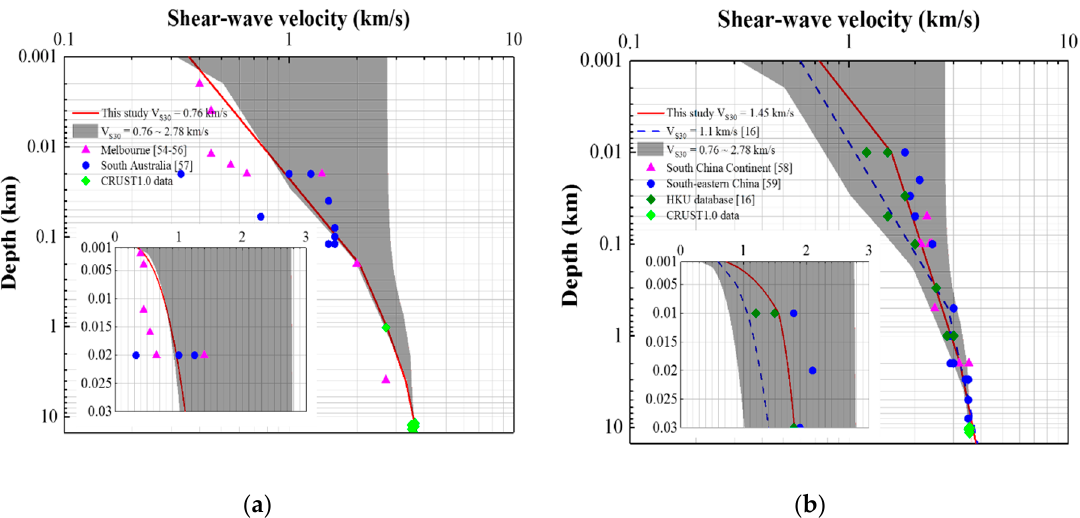
Figure 2. Shear-wave velocity profile: ( a ) SEA; ( b ) SEC, in which CRUST1.0 is a global crustal database (https://igppweb.ucsd.edu/~gabi/crust1.html, last accessed in January 2019), the shear wave velocity data can be found in the “Supplementary Materials”. Table 3. Parameter values for modelling shear wave velocity (SWV) profiles for South-Eastern Australia (SEA) and South-Eastern China (SEC).